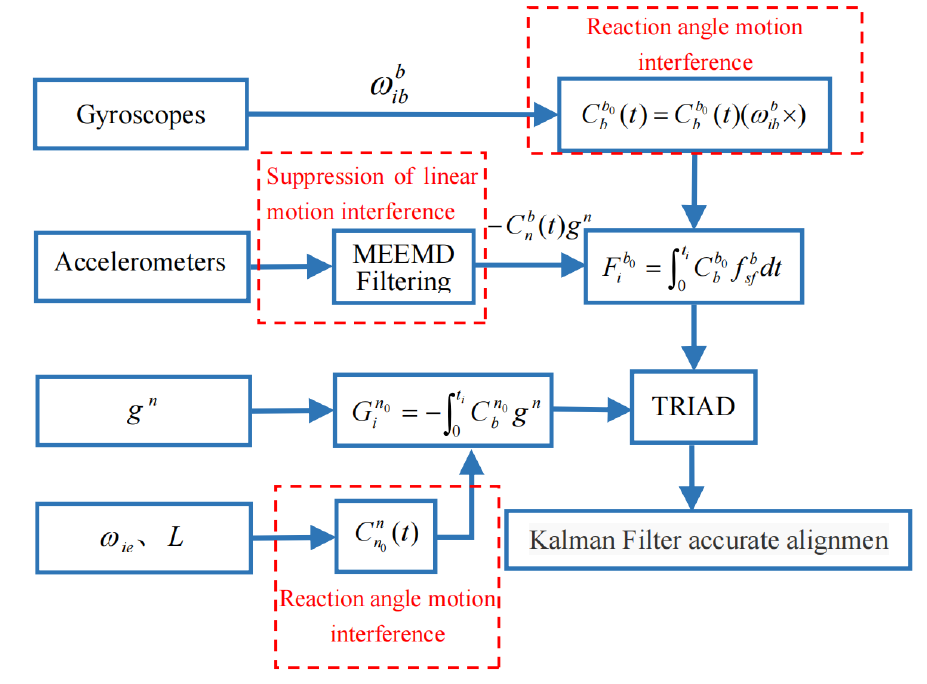
Figure 2. Process of initial